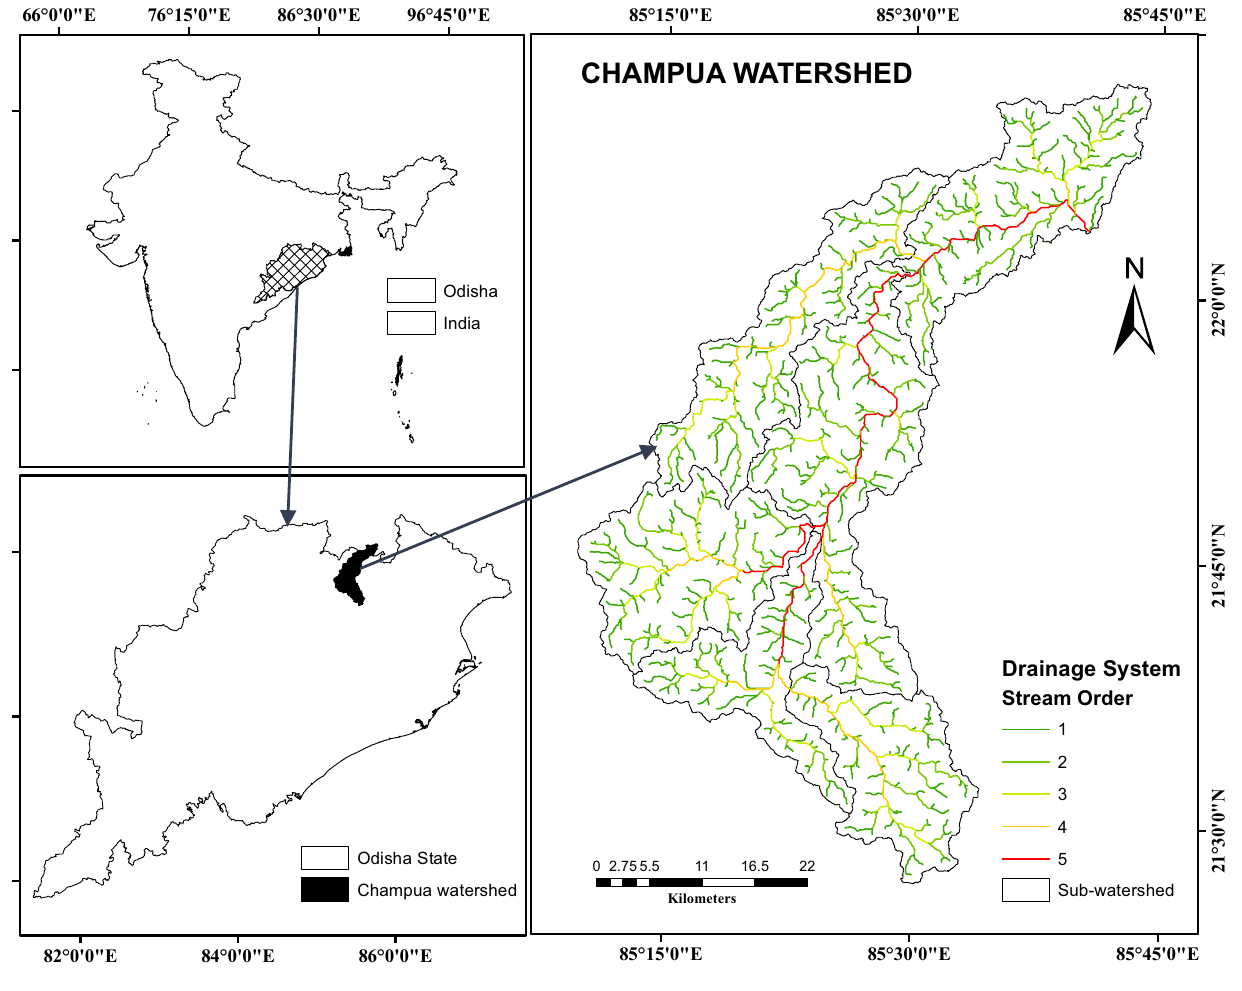
Fig. 1 Location map of the study area (Champua